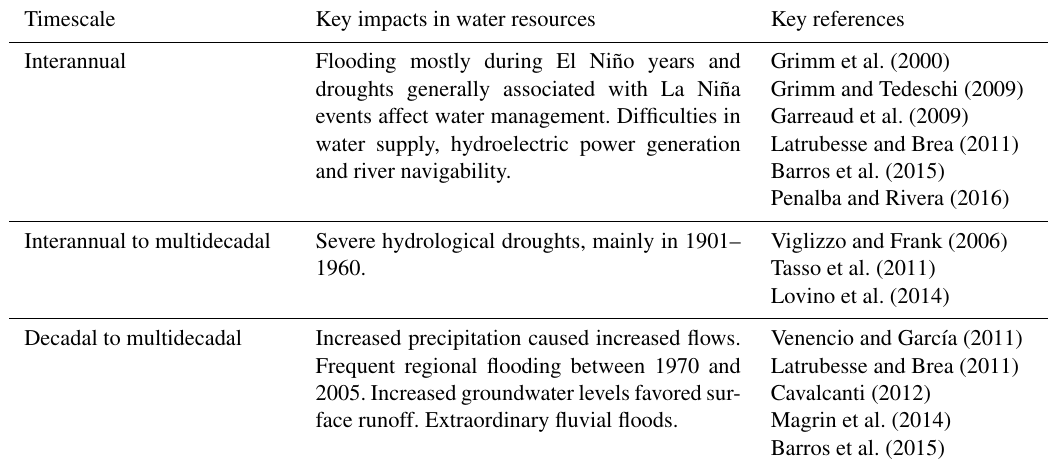
Table 3. Impacts of hydroclimate variability and its extremes in water resources. The first column shows the main timescale of variability affecting the study